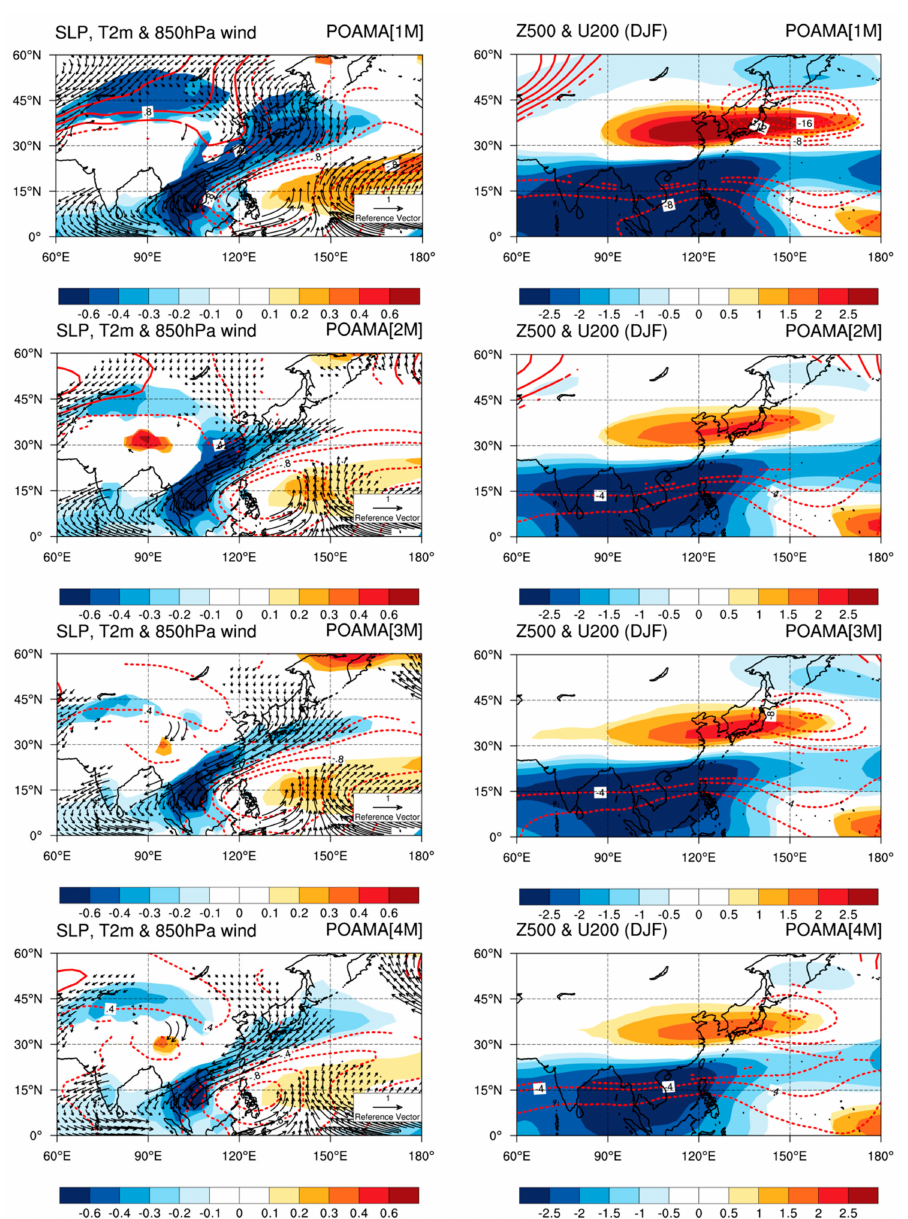
Figure 11. Same as Figure 9 except for one-month (1M), two-months (2M), three-months (3M) and four-months lead